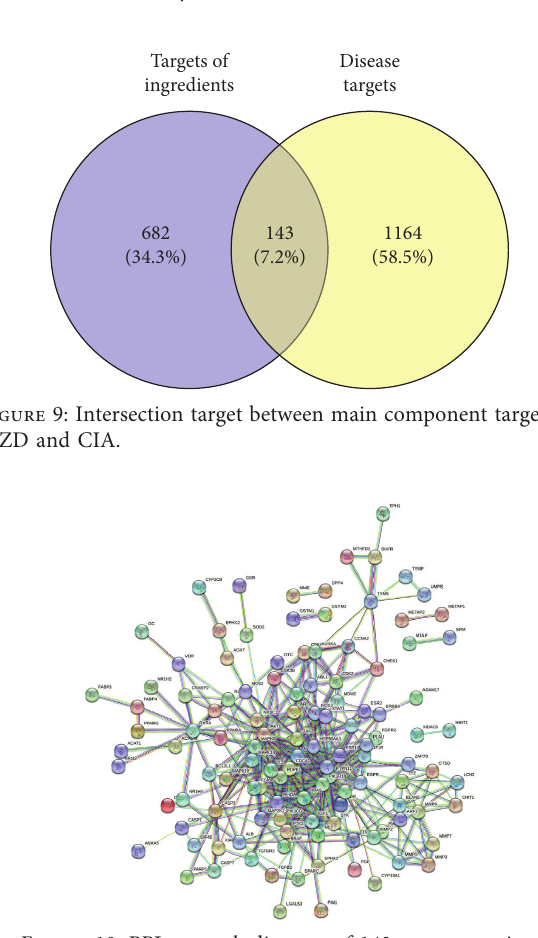
Figure 10: PPI network diagram of 143 target proteins.